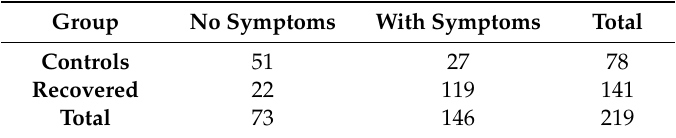
Table 2. Participants groups divided by condition of No symptoms and Symptoms at the moment of the